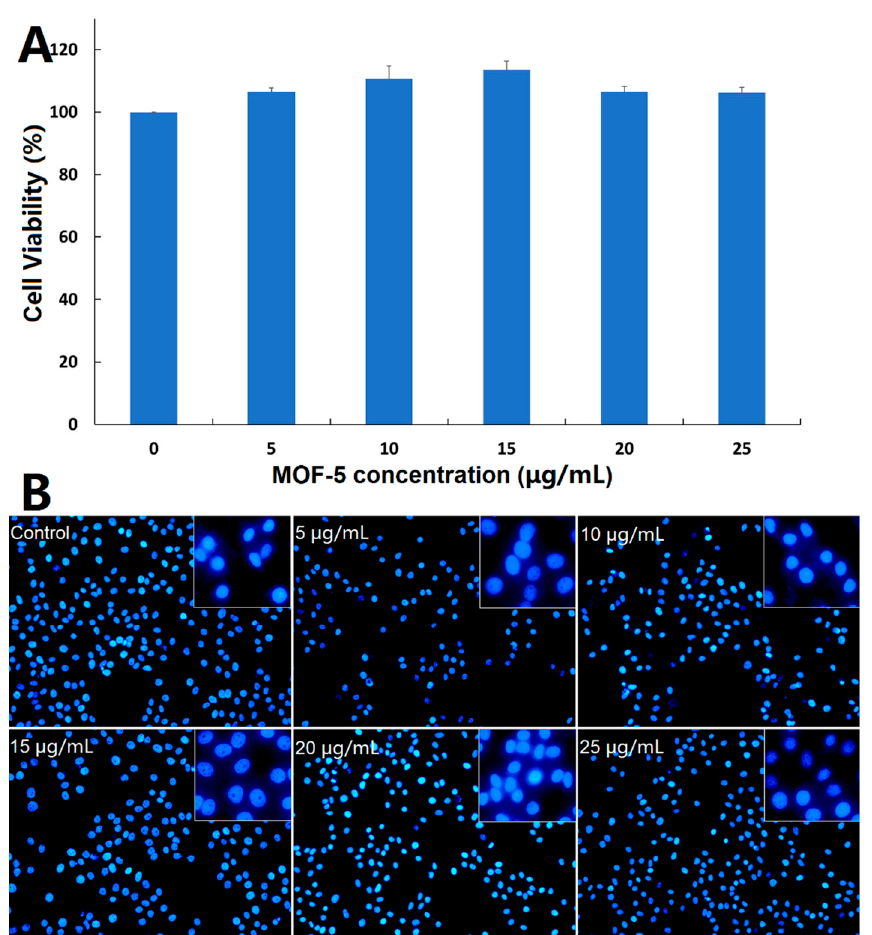
Figure 8. ( A ) Cytotoxicity study of MOF-5 on HepG2 cells determined by MTT assay; ( B ) Fluorescent microscopic images of DAPI-stained HepG2 cells following 24-h treatment with different concentrations of MOF-5.